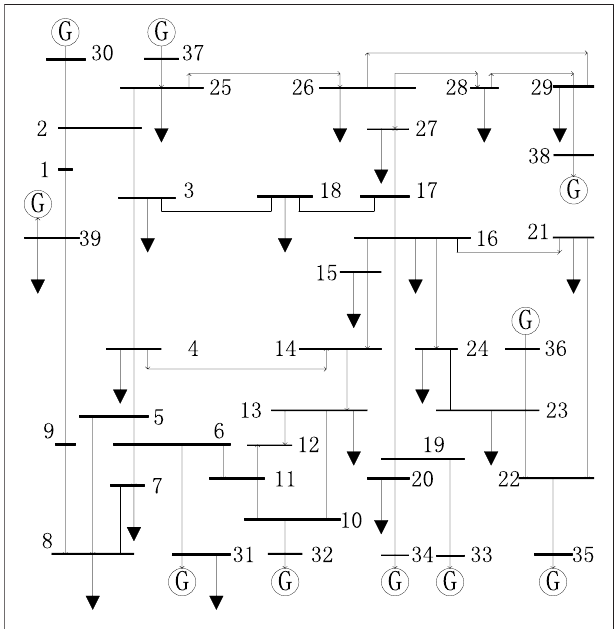
FIGURE 2 | IEEE-39 bus power system network